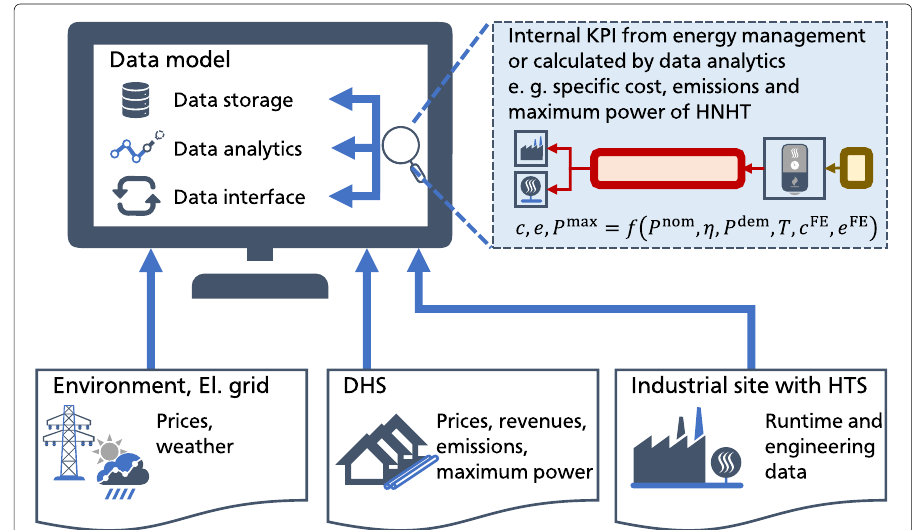
Fig. 3 Schematics of the data model with the connected systems and its acquired data. Necessary KPI can be accessed by an advanced energy management or are being processed within the data